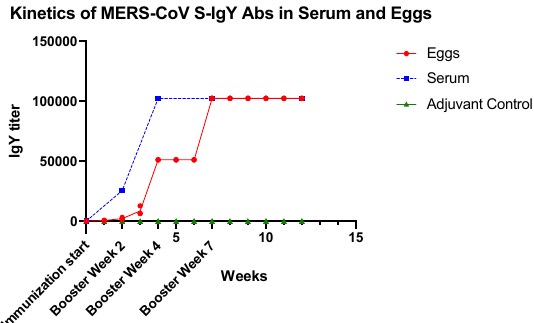
Figure 3. Western blot analysis of anti-MERS-COV rS1 IgY antibodies. (Left) The S1 protein of MERS- COV was subjected to SDS-PAGE under reducing conditions; (Right) Western blot analysis of the anti- S1 IgY antibody response. SDS gels were electrically transferred onto nitrocellulose membranes and probed with IgY from immunized and nonimmunized hens (marker: molecular maker; lane A: S1- immunized IgY; lane B: adjuvant-immunized IgY). The strips were processed separately and pasted beside each other for documentation.